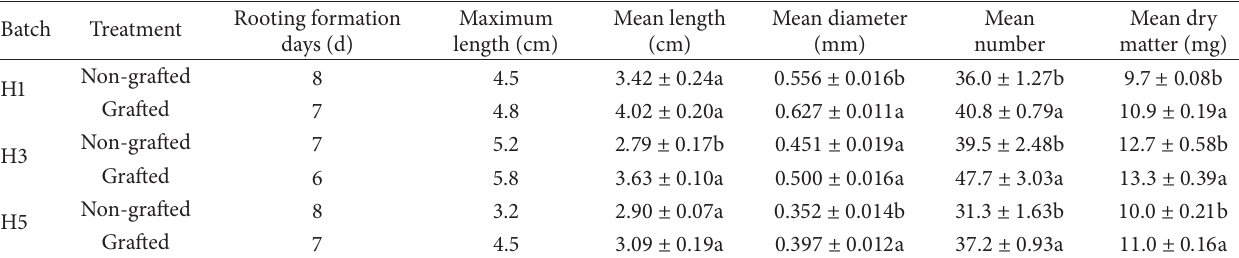
Table 2: The rooting characteristics of the non-grafted and grafted cuttings “Jinba”.